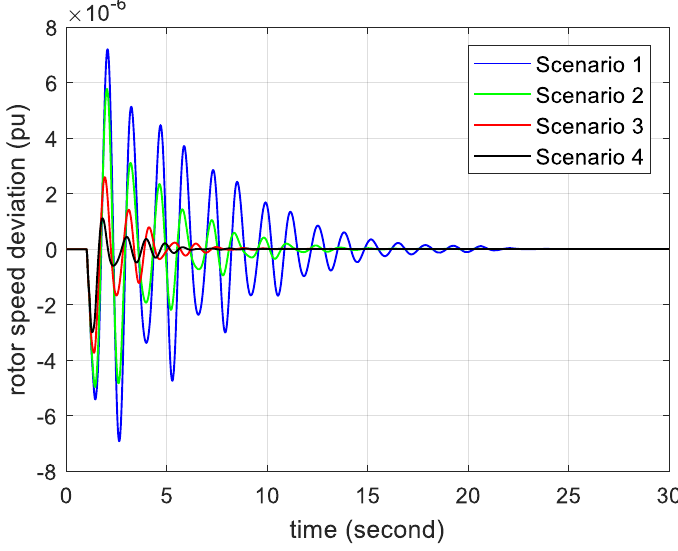
Figure 6. Rotor speed responses of G3.